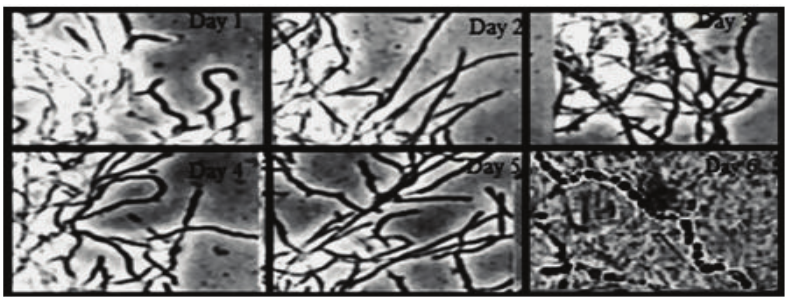
Fig. 1 – Typical morphology of S. roseosporus at different time Fig. 1 Typical morphology of S. roseosporus at different time intervals